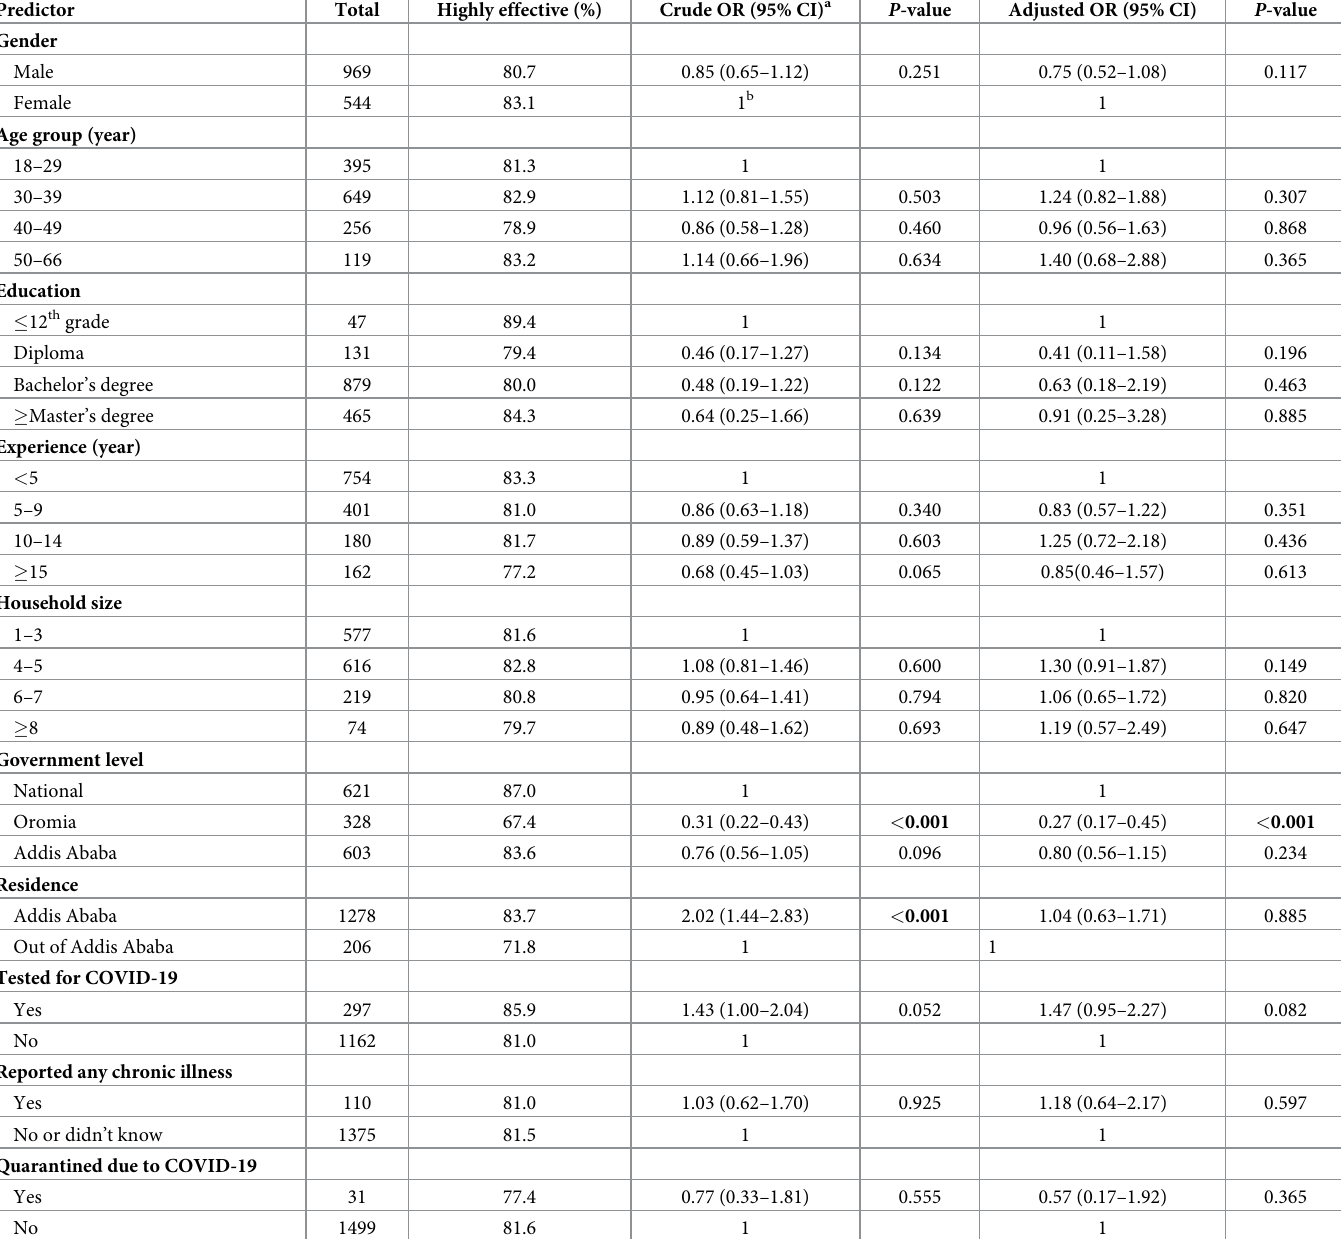
Table 3. Factors associated with perceived effectiveness of facemask in preventing coronavirus infection using bivariate and multivariable logistic regression analy- ses, Addis Ababa, June 2020.